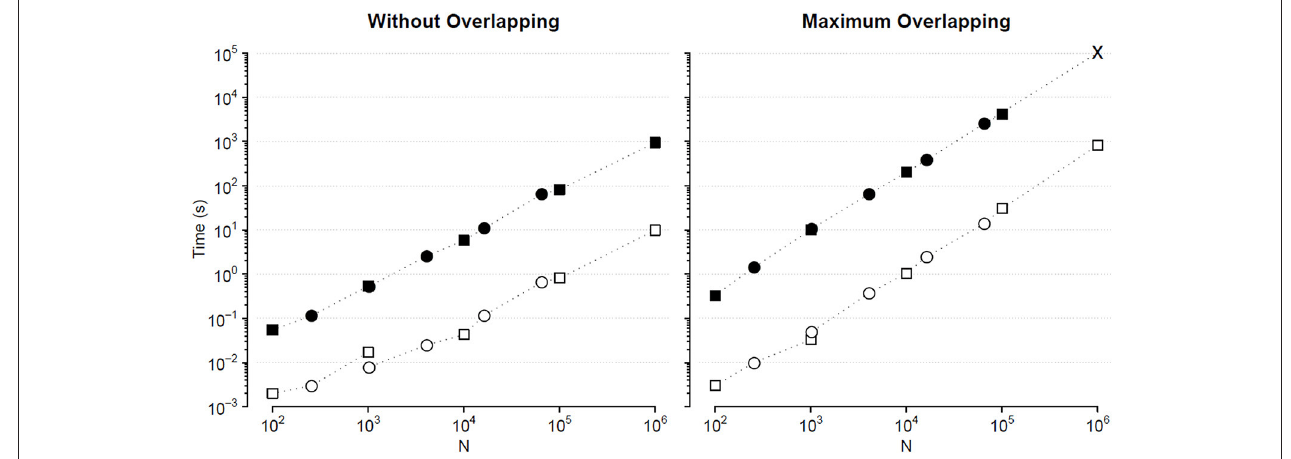
FIGURE 4 | Comparison of F q (n) calculation times (sum of DFA 1 and DFA 2 ) for series of length N . Times for analyzing {wb i } (square) and binomial cascade (circle) series (see text) by traditional (solid symbols) and fast MF DFA algorithm (open symbols): average of 10 runs on a personal computer with Intel i7-7600U CPU at 2.80 GHz, 16 GB RAM and Samsung MZVLW1T0HMLH-000L7 hard disk. As the series length, N , increases, the number of block sizes, n , also increases remaining constant the block-size density of four n values per decade. The calculation time of the traditional algorithm for maximum overlapping and N = 10 6 has been extrapolated (cross symbol).